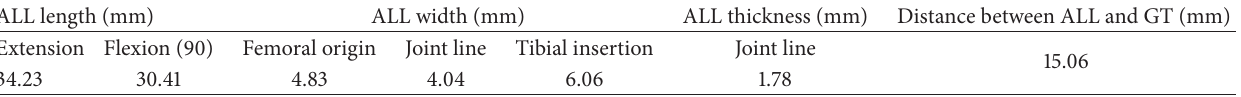
Table 1: Summarizing the length, width, thickness, and distance of the anterolateral ligament (ALL) from Gerdy’s tubercle (GT). ALL length (mm)